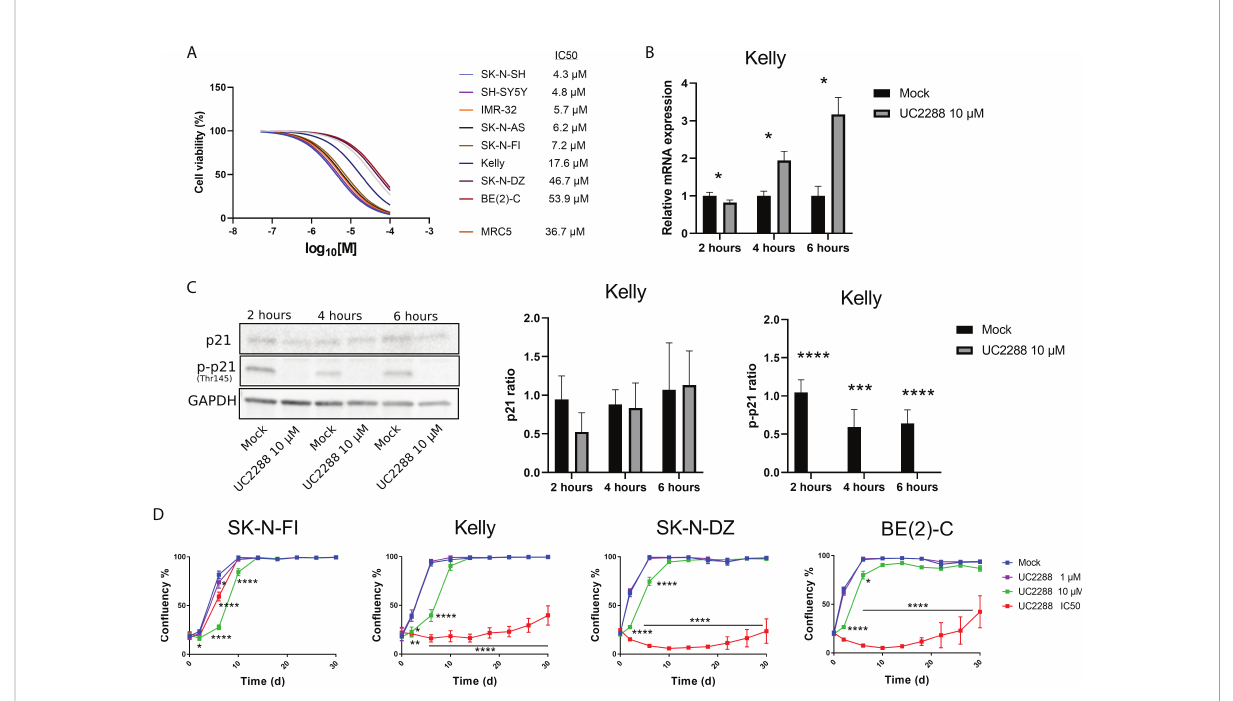
FIGURE 4 Measuring sensitivity to the p21 inhibitor UC2288. (A) Dose – response curves for cell viability after 72 hours of UC2288 treatment in eight NB cell lines and the fi broblast cell line, MRC5. Cell viability was assessed using MTS-assay to determine the IC 50 values of UC2288 as single agents. Concentration ranges from 50 µM to 0.01 µM of UC2288, were added. n=3. (B) p21 inhibition assays performed on Kelly with UC2288 at a concentration of 10 µM at three time points. A reduction in mRNA was observed after 2 hours followed by an increase at 4 hours and 6 hours post-treatment. * = p<0.05, not signi fi cant p>0.05, Student´s t-test. Mean ± SD, n=3. (C) Western blot analysis showing protein expression of p21 (21 kDa), p-p21 (Thr145) (32 kDa) and loading control GAPDH (37 kDa) in the Kelly cell line following treatment with UC2288 at a concentration of 10 µM at three time points. The expression of p21 was not altered whereas the expression of p-p21 was reduced at all three time points investigated. **** = p<0.0001 not signi fi cant p>0.05, Student´s t-test. Mean ± SD, n=4. (D) Cultured cells were exposed to the indicated treatment (mock/UC2288) and analysed using live cell imaging with the IncuCyte at the indicated time points. The con fl uence shows the cellular densities of each cell line measured over 30 days. The lowest tested dose (1 µM) showed delay in the SK-N-FI cell line. Following either IC 50 concentration or 10 µM all cell lines showed regrowth capacity, albeit after an extended lag period.* = p<0.05, **= p<0.01, *** = p<0.001, not signi fi cant p>0.05. Two-way ANOVA with Bonferroni post hoc test. Mean ± SEM of 5